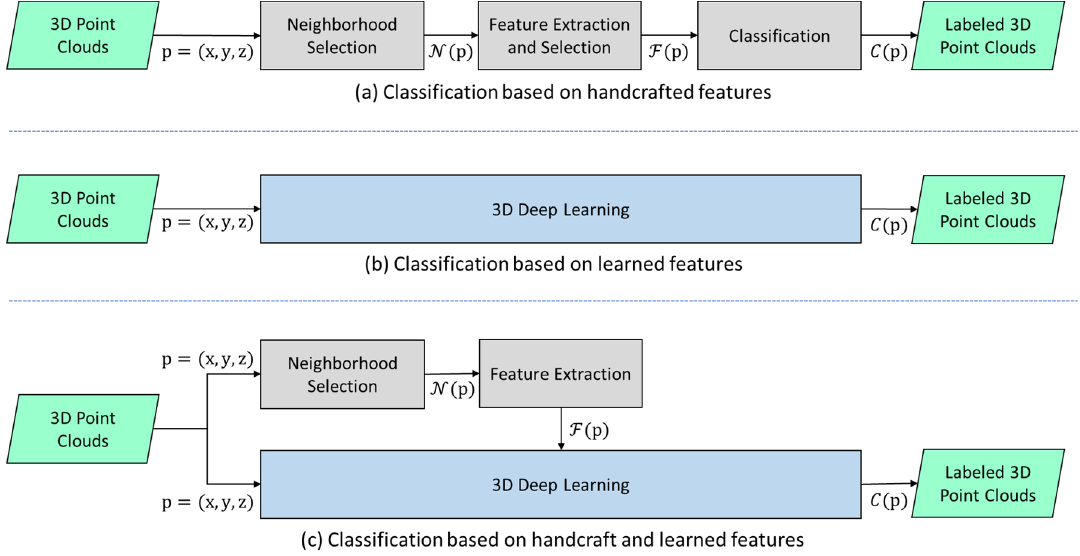
Figure 1. Flowcharts of point cloud classification: ( a ) traditional methods based on handcrafted features; ( b ) deep learning method based on learned features; and ( c ) proposed method based on handcrafted and learned features.